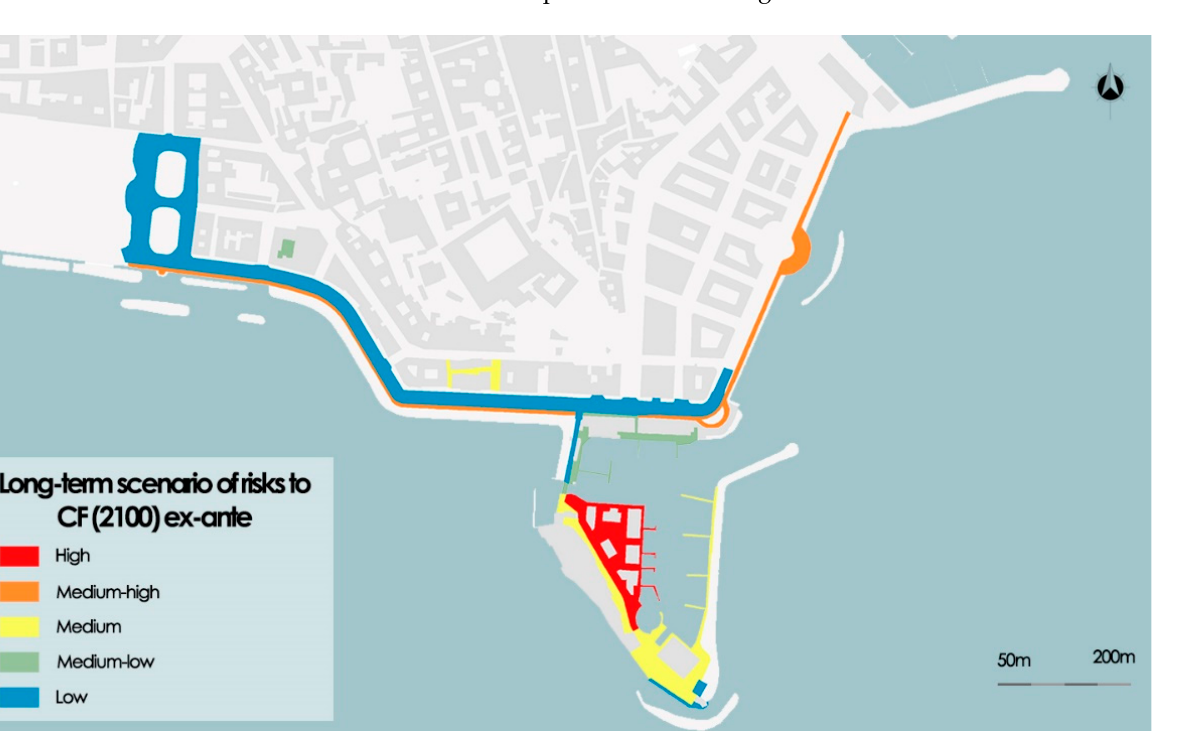
Table 7. Allocation of risk classes to Coastal Flooding.